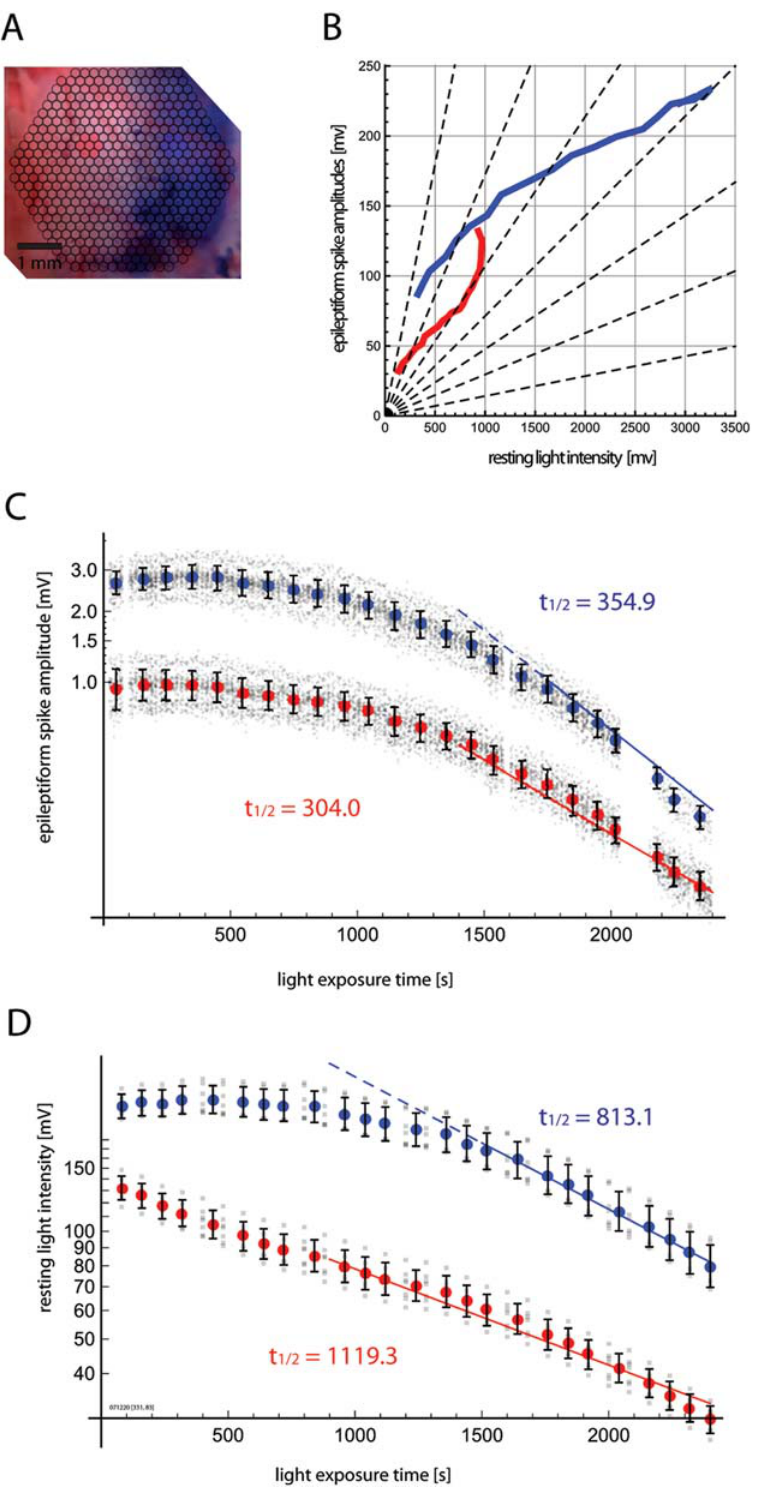
Figure 3. Staining quality affects D F and F RLI differently. A. Dura in the left half of the field was protected with a small piece of tissue paper during dura permeabilization and staining. Blue and red highlights indicate the selected areas for which signal was plotted in subsequent panels. B. Epileptiform spike amplitudes ( D F epileptiform ) and resting light intensity (F RLI ) were measured over time, as in Figure 2, and plotted against each other. D F epileptiform /F RLI is nonlinear over the experiment. Furthermore, well-stained areas (blue) show different patterns of D F epileptiform /F RLI change compared to poorly-stained areas (red). C. The timecourse of epileptiform spike amplitude ( D F epileptiform ) is plotted as in Figure 2B. Signal from poorly- stained areas (red) were smaller overall in amplitude, and showed somewhat faster ‘‘bleaching’’ kinetics within the exponential phase. D. Timecourse of resting light intensity (F RLI ) is displayed as in Figure 2C. F RLI was smaller overall in the poorly-stained half. The exponential time constant of the poorly-stained area is much slower, and a large qualitative difference in bleaching kinetics is also evident. These results demonstrate that the staining quality can affect the relationship between D F and F RLI , introducing hard-to-control biases when using the standard D F/F RLI normalization. doi:10.1371/journal.pone.0004041.g003 PLoS ONE |